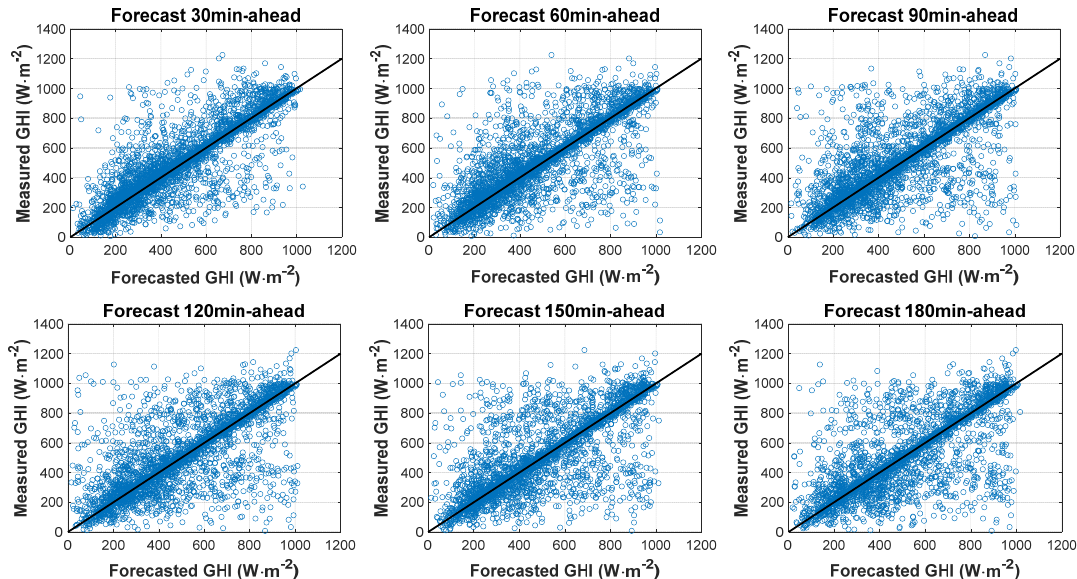
Figure 8. Forecasting GHI values by the model using FY-4A satellite observation versus ground measured values for time horizons from 30 to 180 min.